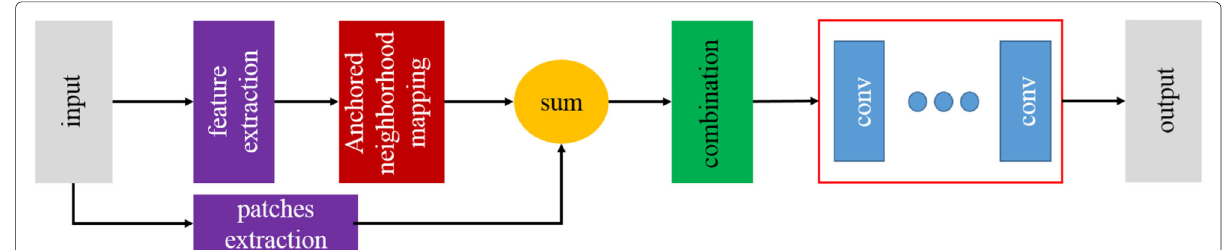
Fig. 3 Illustration of the proposed anchored neighborhood deep network structure for single image SR. It uses a convolution layer to extract low frequency feature and then uses an anchored neighborhood convolution layer to predict the high frequency details. After combining these high frequency patches, we cascade multiple convolution layers to fuse the local similarity patches and refine the image